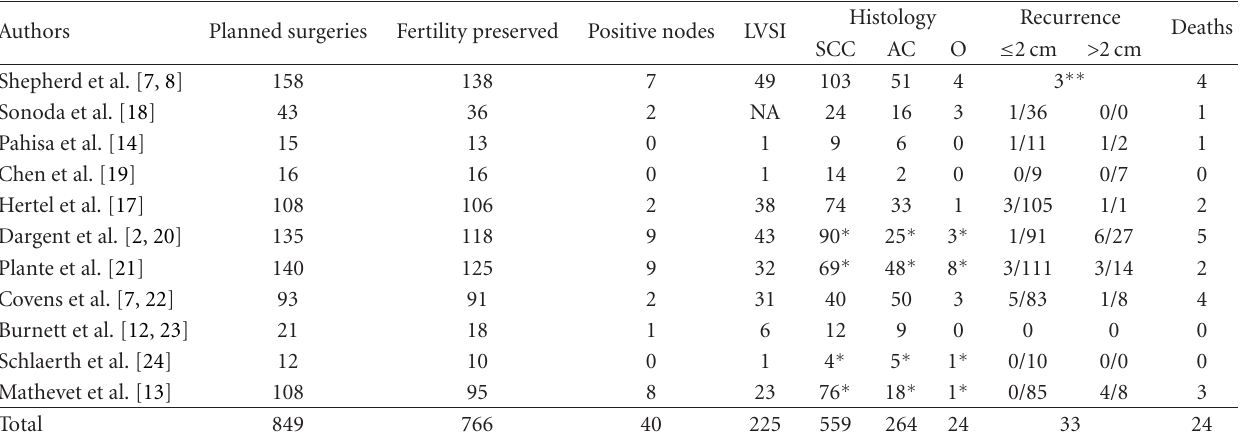
Table 2: Characteristics and oncological outcome of RVT.